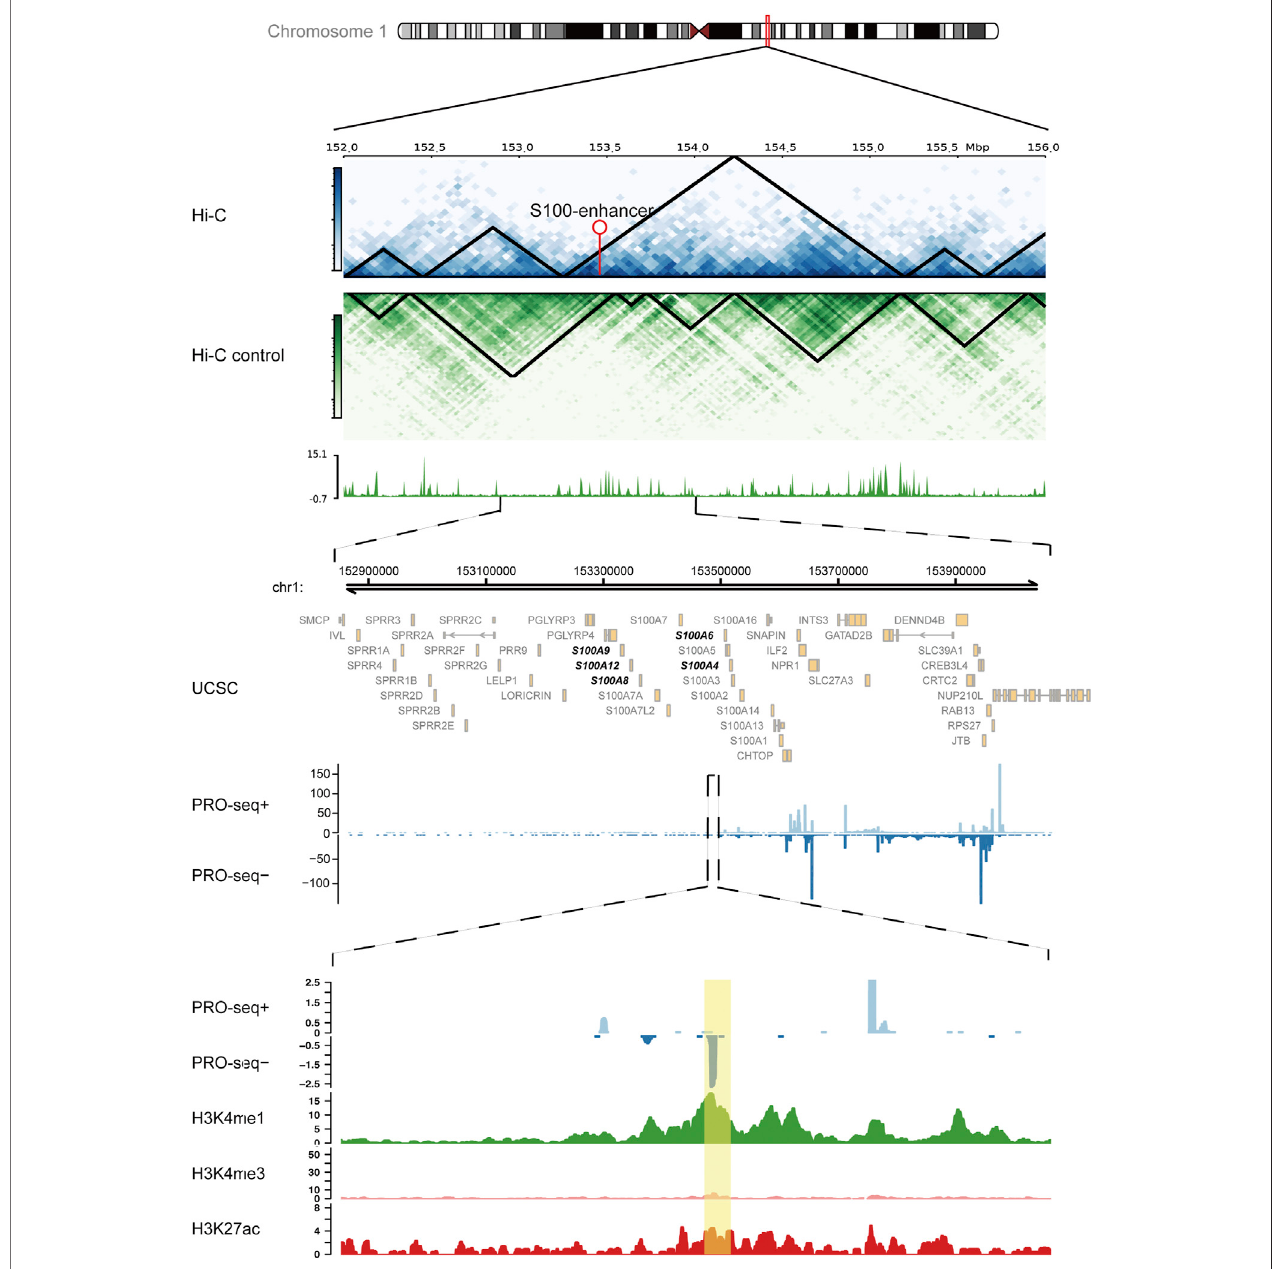
FIGURE 5 | S100-enhancer and correlated genes in the same transcription activation domain (TAD). Upper panel: Hi-C analysis of the genomic region containing the S100-enhancer gene in the K562 cell line, compared with the control cell line. Arrow pointed out the enhancer location. Medium panel: UCSC gene annotations and PRO-seqanalysiswithin±0.5 MbregionoftheS100-enhancergene,including fi vecorrelatedgeneslocatedinthesameTAD(bold).Lowerpanel:PRO-seqanalysisand enhancer-related epigenomic modi fi cation analysis (H3K4me1, H3K4me3, and H3K27ac) within the S100-enhancer gene region. S100-enhancer is highlighted in